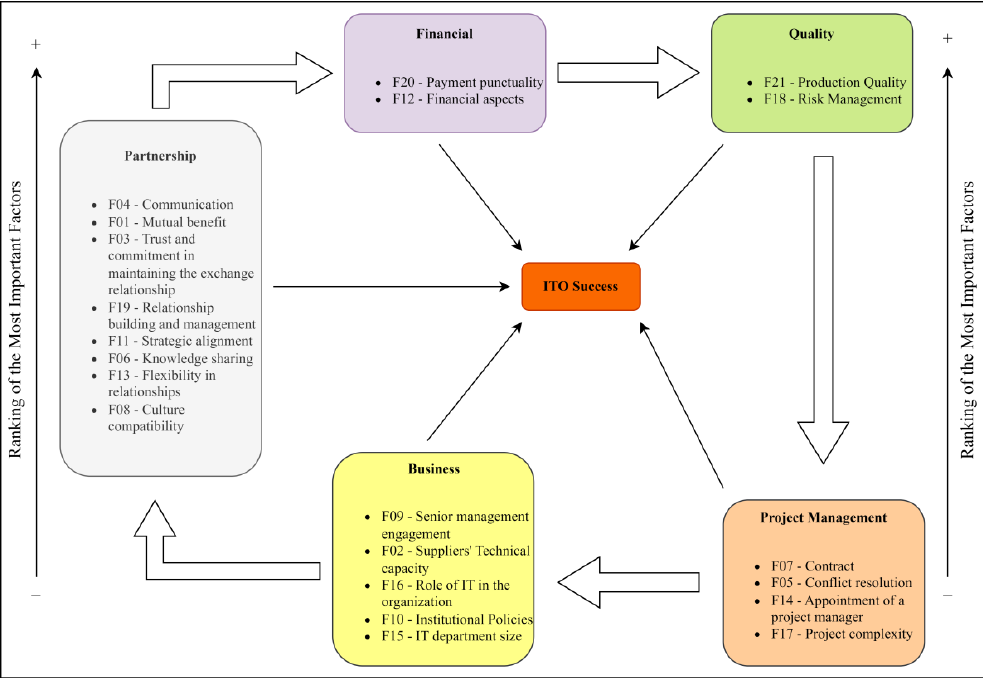
15 of 22 Figure 3. Grouping by conceptual affinities of key factors. After dividing the key factors and based on the ranking of Table 2, a scheme was elaborated inspired by the relationship diagram also used in quality planning. The rela- tionships provided by this new diagram fulfilled the fifth step in the procedure, ensuring